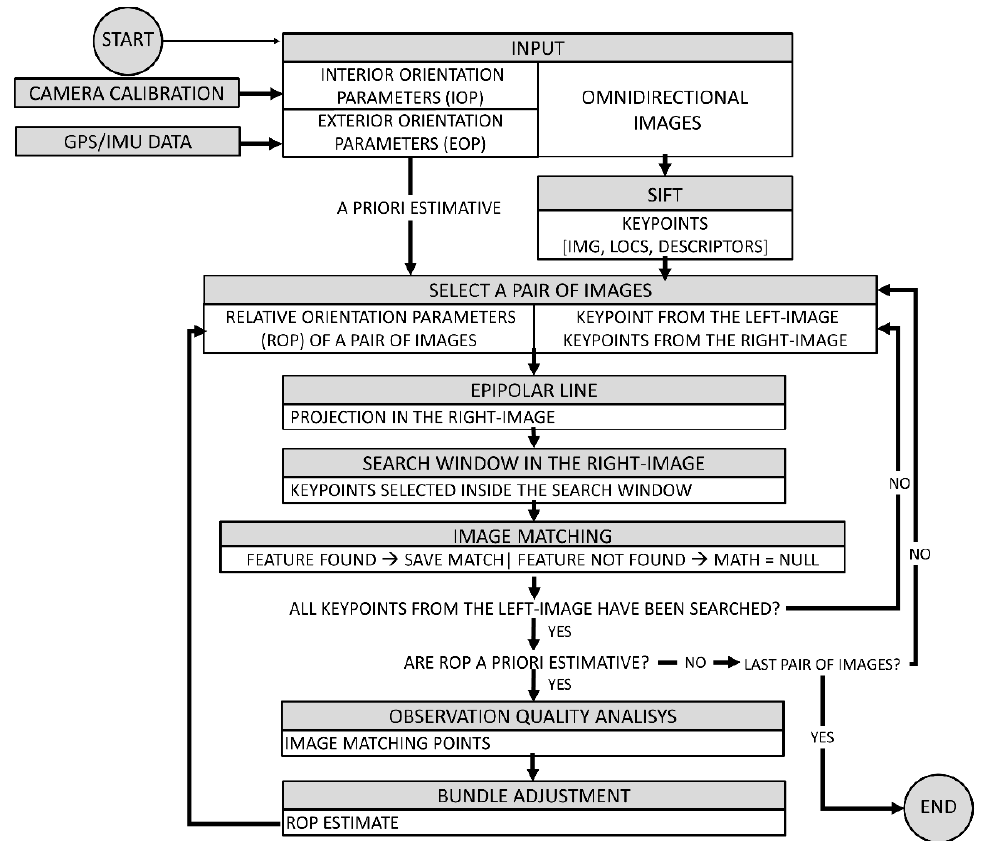
Figure 1. Flow chart of the recursive search space method for fisheye image matching.